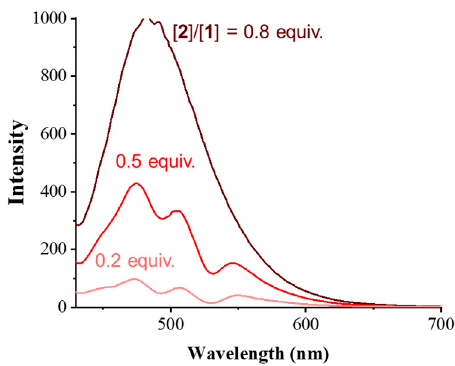
Figure 3. Luminescence spectra of co-assembled supramolecular gels (1 wt%) at a different molar ratio of 2 to 1 in dimethyl sulfoxide.